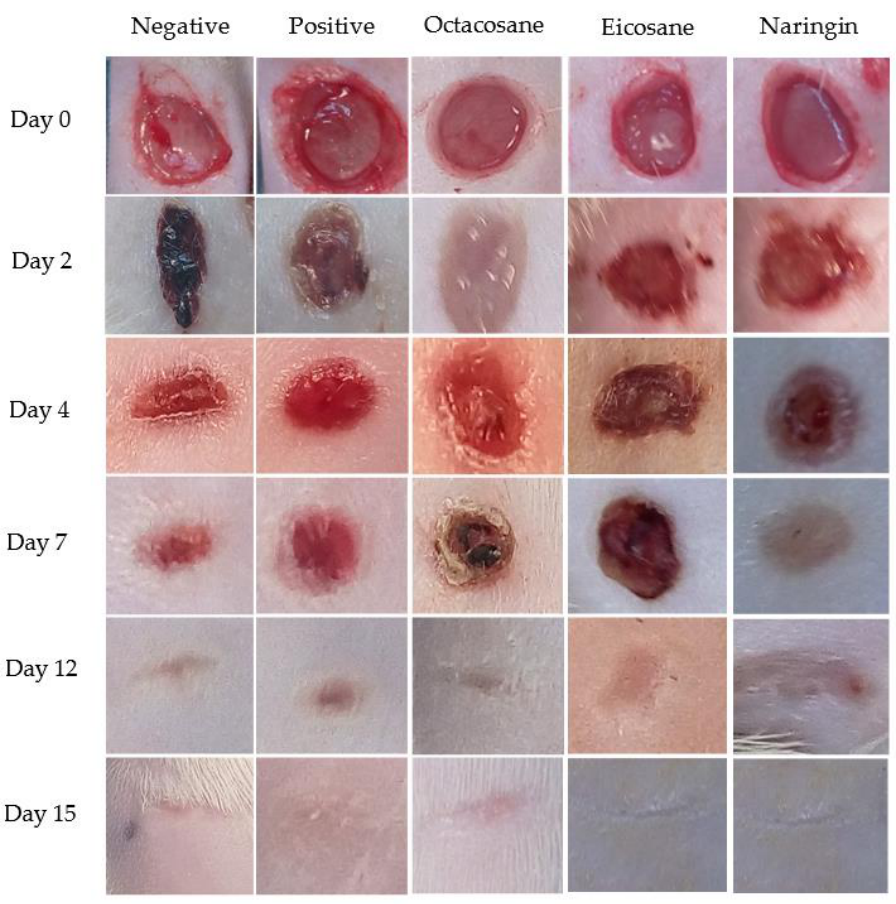
Figure 3. Excised wounds of different treatment groups from the diabetes-induced animal model on different days over a period of 15 days.